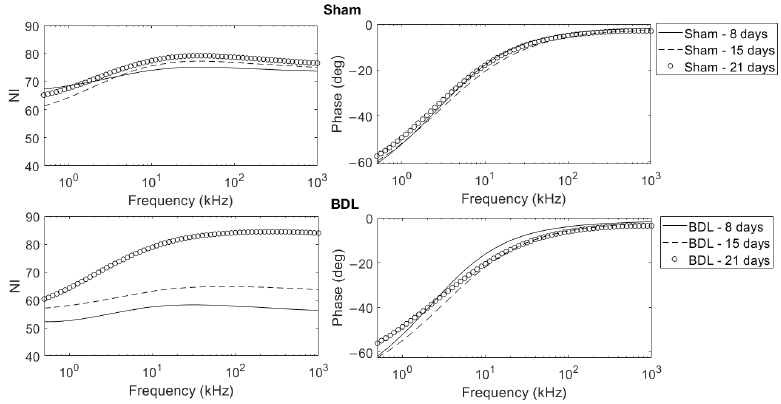
Figure 3. Normalized impedance magnitude and phase curves of sham-operated and BDL liver samples in the range between 500Hz and 1MHz. For each condition (Sham and BDL at 8, 15 and 21 days), three livers were studied. From each liver, three different biopsies were obtained for analysis in triplicates. Therefore, each of the illustrated curves corresponds to the mean value of nine measurements (three mice, each in